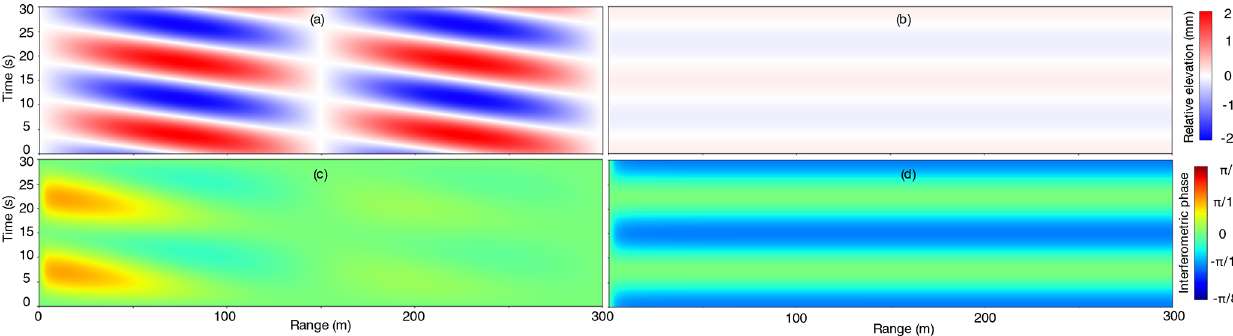
Figure A2. Relative change in the (a) vertical and (b) horizontal distance between the GPRI antenna and the ice surface due to the wave in Fig. A1. Panels c and d represent the resulting interferograms from the isolated motion in panels (a) and (b)